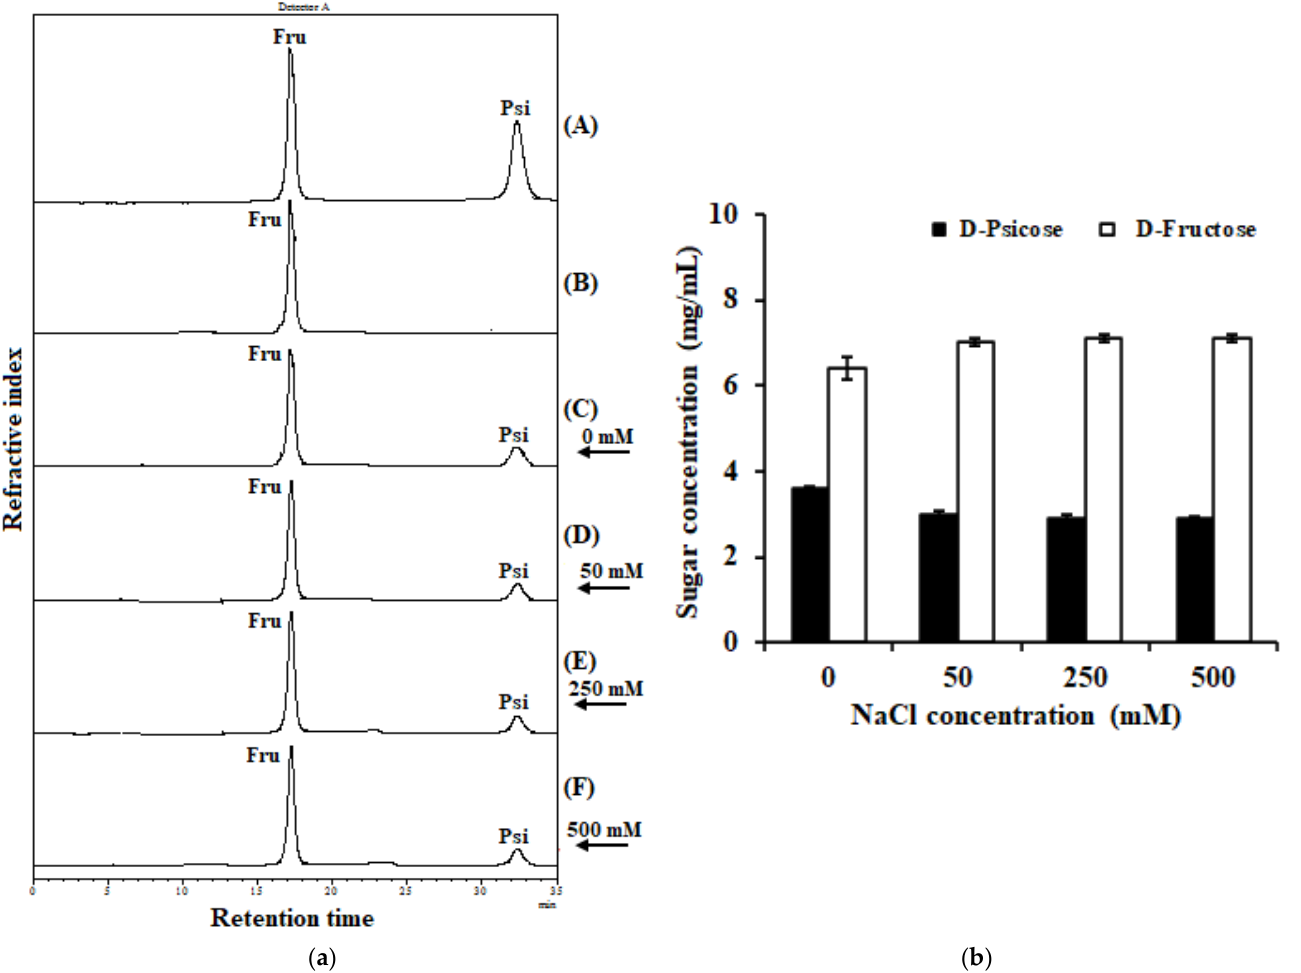
Figure 3. Effect of sodium chloride concentration on IfDPEase activity. ( a ) HPLC analysis profiles of reactions contained 0–500 mM NaCl. The reaction was determined for D ‐ fructose (10 mg/mL) with 5 μ M of the purified enzyme containing 1.0 mM Mn 2+ at 50 °C and pH 7.5 (50 mM Tris ‐ HCl buffer) for 5 min; ( A ) standard D ‐ fructose and D ‐ psicose, ( B ) the reaction with denatured enzyme, ( C ) the reaction without NaCl, ( D – F ) the reaction under 50, 250, and 500 mM NaCl, respectively. ( b ) Changing concentrations of D ‐ fructose and D ‐ psicose after incubation under various concentrations of NaCl. Values are the mean of three replications ± standard deviation.